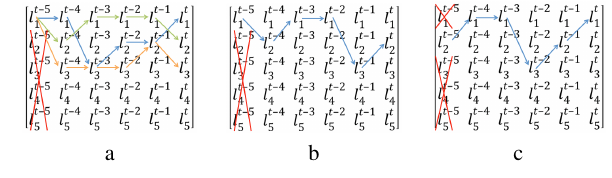
Table 3. Path Score calculation left to right